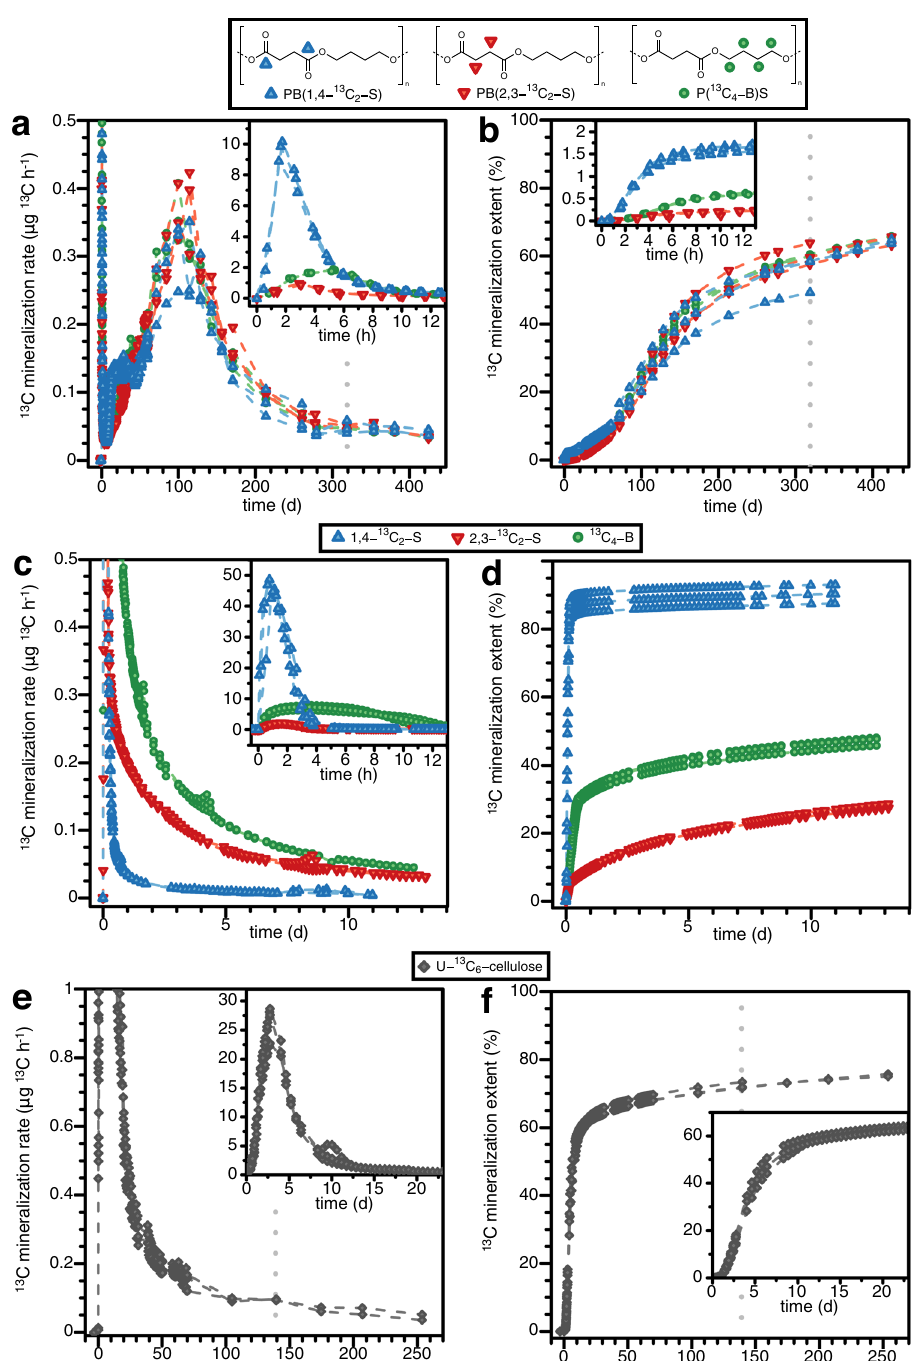
Fig. 1 | Mineralization of 13 C-labelled poly(butylene succinate), monomers and cellulose during soil incubations. Measured mineralization rates ( a , c , e ) and resulting calculated cumulative mineralization extents (i.e., C mineralized ; b , d , f ) for the three variants of 13 C-labelled poly(butylene succinate) (PBS) (i.e., PB(1,4- 13 C 2 -S), blue up-triangles); PB(2,3- 13 C 2 -S), red down-triangles); and P( 13 C 4 -B)S, green circles — a , b ), the corresponding 13 C-labelled succinate and butanediol monomers (i.e., 1,4- 13 C 2 -S, blue up-triangles; 2,3- 13 C 2 -S, red down-triangles; and 13 C 4 -B, green circles — c , d ), and U- 13 C 6 -cellulose (grey diamonds — e , f ), during soil incubations. The ordinate units for the insets in a – c , e , f are identical to those of the ordinate units of the respective main panels. Dashed lines between measurement data